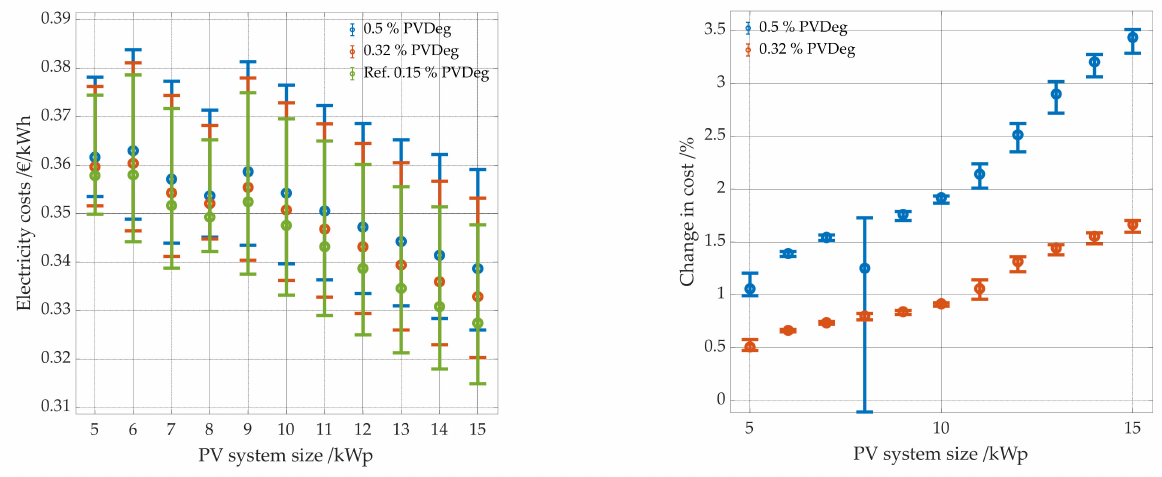
Figure 25. Electricity costs as a function of the PV System size ( left panel) and the change in cost as a function of PV system size ( right panel). Shown in color are different levels of degradation of the PV